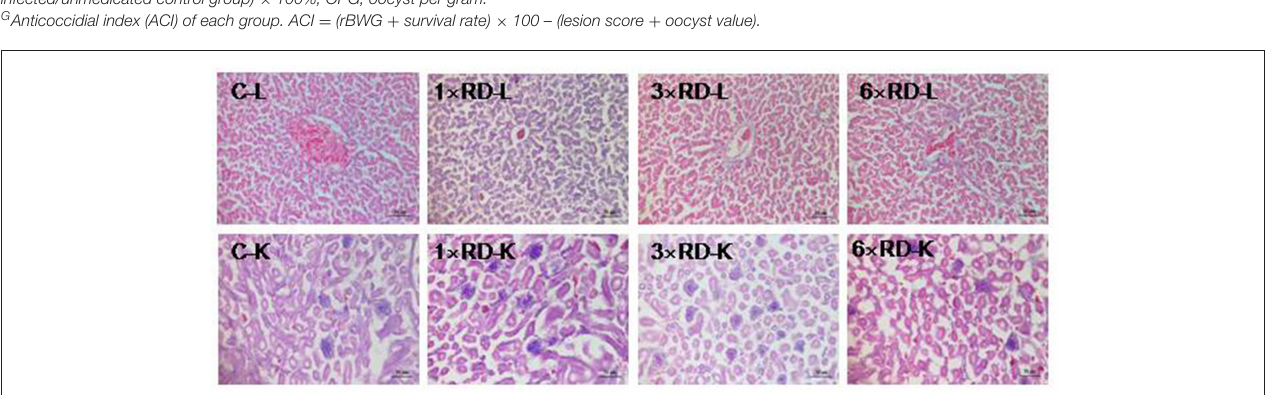
the QHP-treated chicks compared with the controls, as